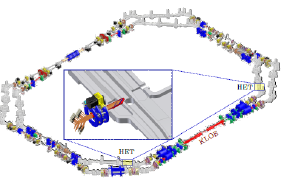
Figure 2. Schematic view of the DA Φ NE ring with the HET